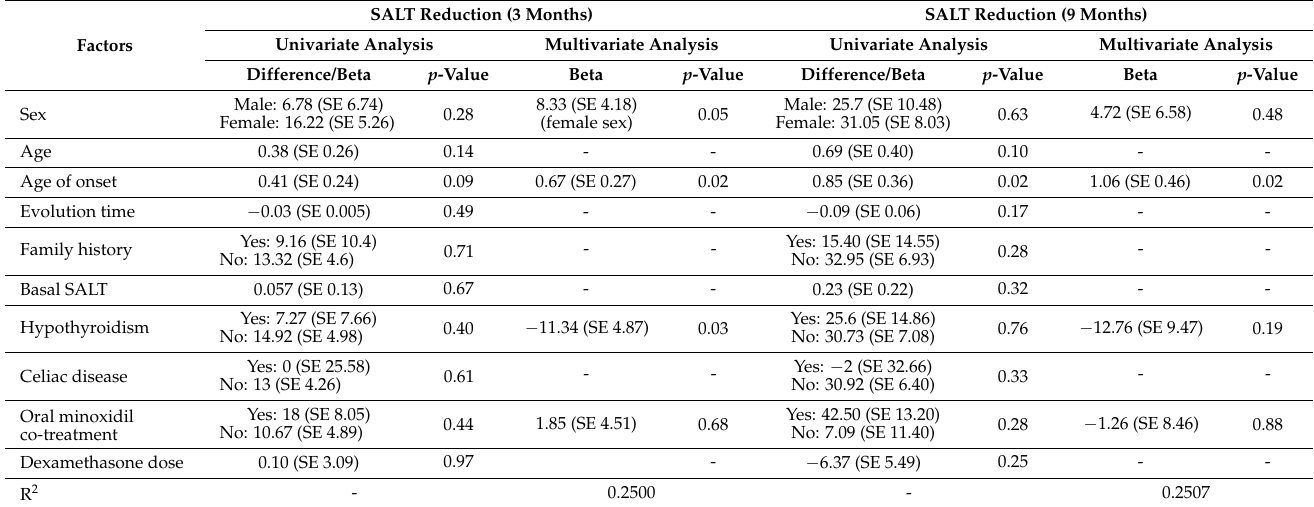
Table 3. Associated factors analysis for SALT reduction at 3 and 9 months.